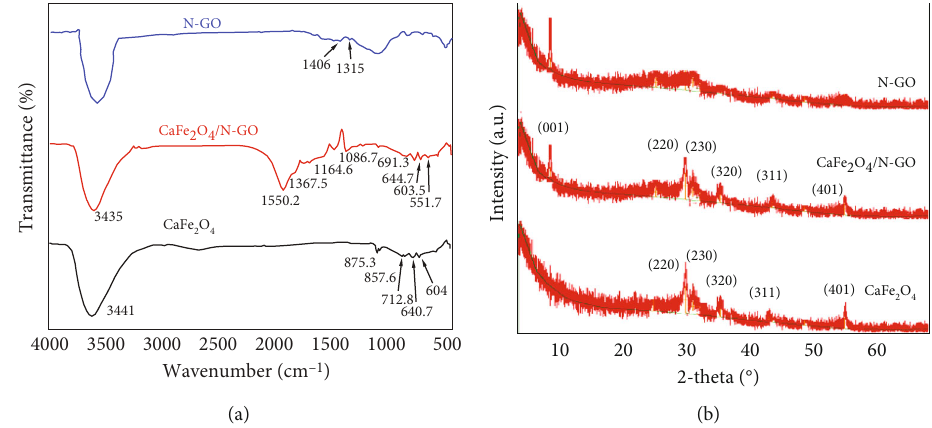
Figure 2: FT-IR (a) and XRD (b) of the synthesized CaFe